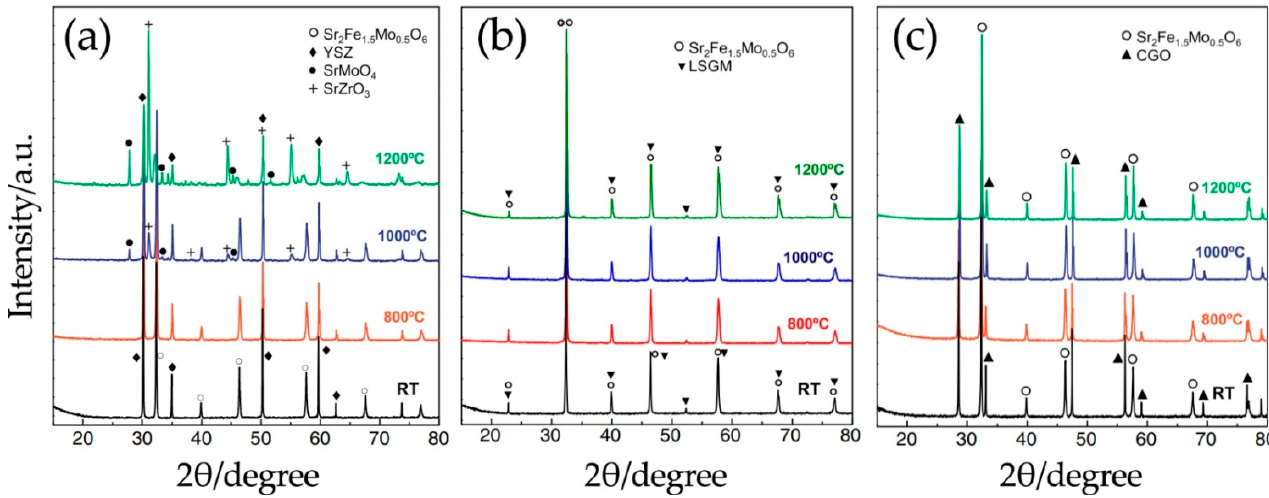
Figure 15. XRD patterns of different mixtures at room temperature and after high-temperature treatment: Sr 2 Fe 1.5 Mo 0.5 O 6- δ and YSZ ( a ), Sr 2 Fe 1.5 Mo 0.5 O 6- δ and LSGM ( b ) Sr 2 Fe 1.5 Mo 0.5 O 6- δ and GDC ( c ). Reproduced with permission [91]. Copyright 2013,